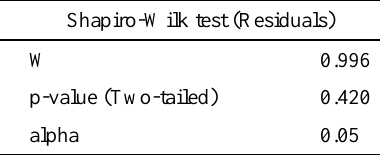
Temperature ( o C)